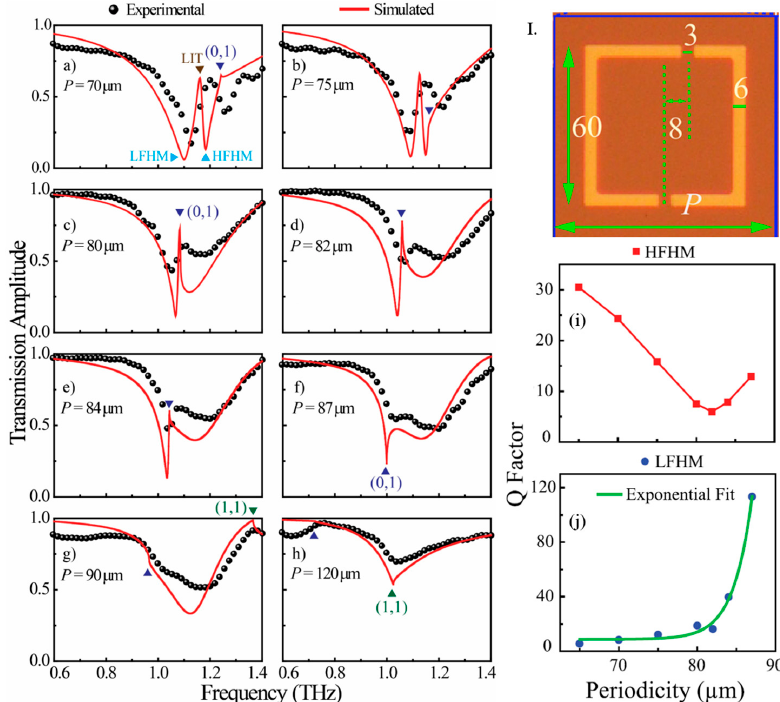
Figure 4. Coupling of hybridized resonator modes to a lattice mode. (I) The unit cell with dimensions in μm . ( a – h ) Experimental (black spheres) and simulated (red solid lines) transmission amplitude of a terahertz asymmetric split ring resonator array with the lattice period varying from P =70 to 120 μm . The split modes, low frequency hybrid mode (LFHM) and high frequency hybrid mode (HFHM), are indicated alongside the lattice-induced transparency (LIT) in ( a ). The fundamental lattice mode (0,1) and the (1,1) order lattice mode are indicated by the dark blue and green triangles, respectively. ( i , j ) Q -factor of the HFHM and LFHM of the asymmetric metamaterial for varying periodicities. Adapted with permission from ref [36], AIP